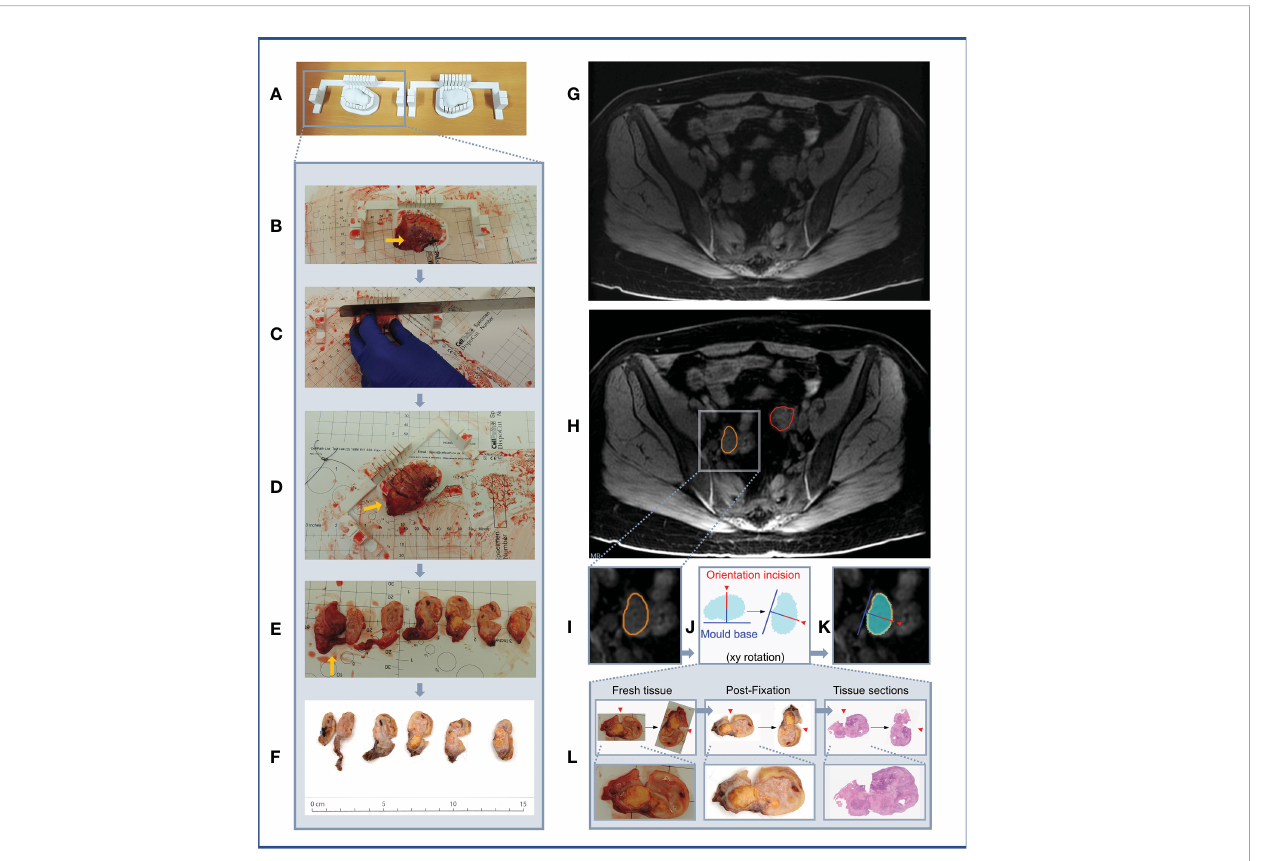
FIGURE 11 Case 5. (A – F) Demonstration of 3D mould-based histological processing work fl ow, with the right ovary as a representative example. Yellow arrow: Fallopian Tube. (G – L) Overview of co-registration between radiology and tissues. (A) Right and left moulds and corresponding tumour replicas. (B) Right ovary placed within corresponding mould. (C) Partial orientation incision placed across specimen using in-built orientation guide. (D) Specimen sliced within mould. (E) Fresh 5mm thickness tissue slices resulting from slicing within mould. Notches from orientation incision allow slices to be orientated in relation to each other. (F) Tissue slices following formalin fi xation. (G) MRI image. (H) MRI image with bilateral ovarian segmentations overlayed (orange: right ovary, red: left ovary). (I) Magni fi ed image of segmented right ovary. (J) Computationally derived expected outline of the corresponding tissue slice and mould base position, rotated on the xy plane to correspond to the base position speci fi ed at the segmentation step. The red arrow and segment represent the angle and depth of the in-built orientation incision. (K) Right ovarian segmentation with tissue outline and mould base overlayed. (L) The orientation incision allowed tissue lice orientation to be preserved across processing steps, from the fresh, fi xed to sectioned tissue stages (haematoxylin and eosin stained section